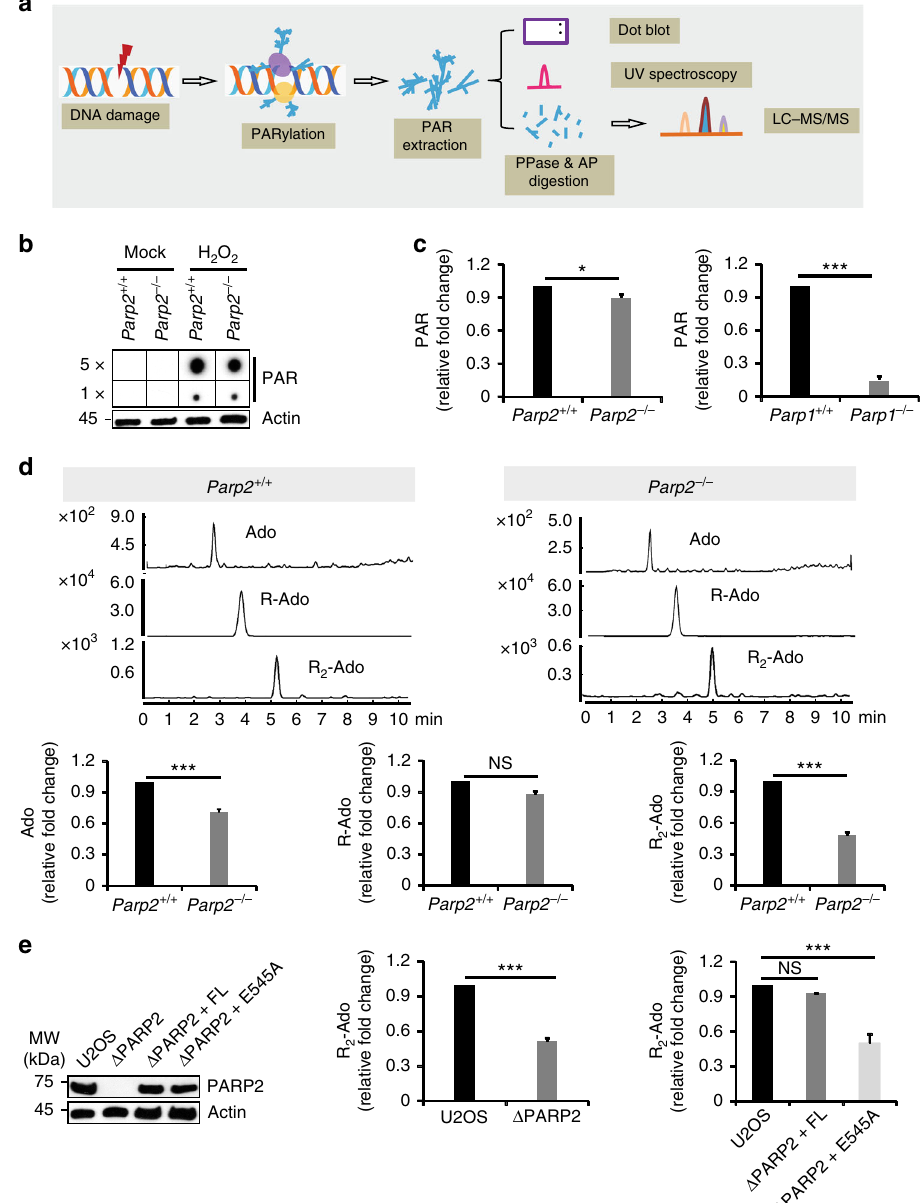
Fig. 1 Loss-of-PARP2 affects the branched PAR chain formation. a Diagram depicting the procedure of sample preparation for dot blot, UV spectroscopy or mass spectrometry. Wide type or Parp2 − / − MEFs were treated with 500 μ M H 2 O 2 for 10 min to induce DNA damage. PAR was extracted and followed by digestion with pyrophosphatase (PPase) and alkaline phosphatase (AP) prior to LC – MS/MS. b Dot blot assays were performed with anti-PAR antibody. 5X means fi ve-fold loading samples. Actin was used as the control of cell lysates (monoclonal antibody, Sigma A2228). c Depletion of PARP2-induced minor reduction of total PAR in response to DNA damage, whereas lacking PARP1 remarkably suppressed total PAR level. The levels of PAR were examined at 259 nm using UV spectroscopy. d Mass spectrometry detection of adenosine (Ado), ribosyladenosine (R-Ado) and diribosyladenosine (R 2 -Ado). LC – MS/ MS quantitative analysis showed that Ado (terminal PAR unit) and R 2 -Ado (branched PAR unit) were remarkably reduced in PARP2-de fi cient cells, but not R-Ado (linear PAR unit). e Only full length PARP2, but not the E545A mutant restores the branched PAR chain formation. PARP2 was deleted in U2OS cells and reconstituted with either full length PARP2 ( Δ PARP2 + FL) or the E545A mutant ( Δ PARP2 + E545A, left panel). The levels of R 2 -Ado were measured by LC – MS/MS (middle and right panels). Data are represented as mean ± s.d. as indicated from three independent experiments. Signi fi cance of differences was evaluated by Student ’ s t -test. NS: non signi fi cant; *statistically signi fi cant ( p < 0.05); ***statistically signi fi cant ( p <